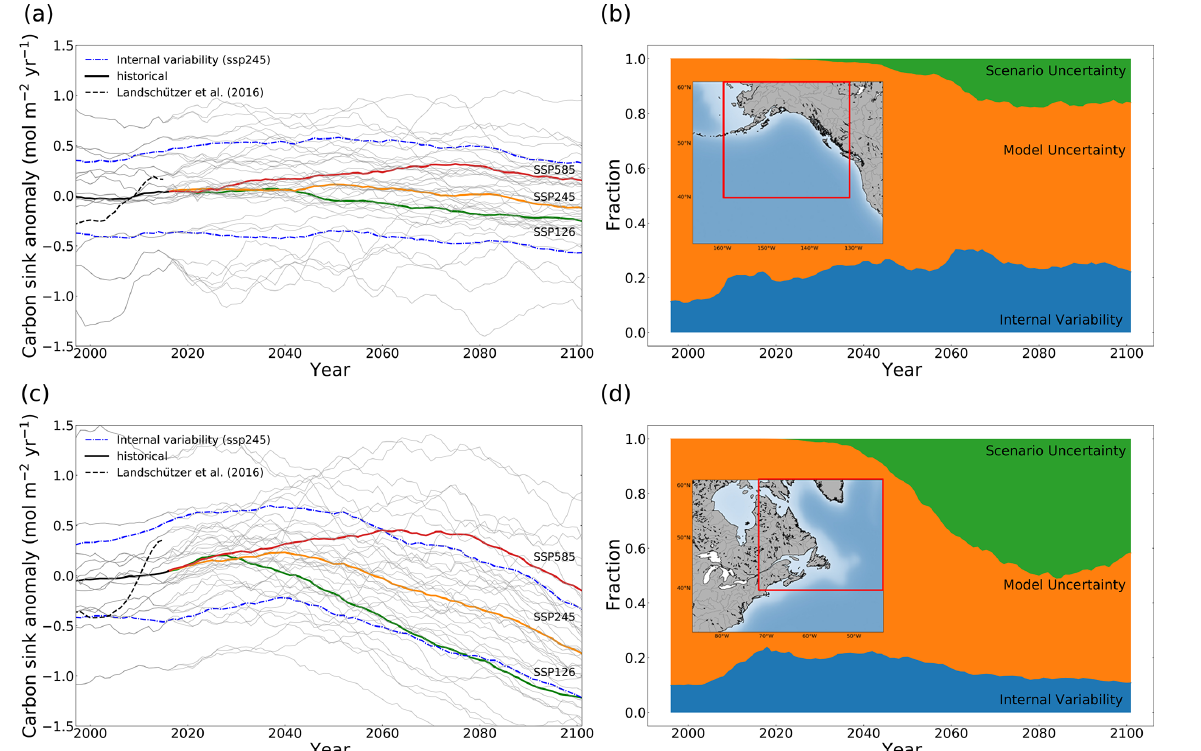
Figure 4. (a, c) Thick lines are multi-model mean time series of anomalies relative to the 1995–2015 mean. All model time series averaged for the means are plotted in grey lines in the background. The black dashed line shows the Landschützer et al. (2016) SOM-FFN product. The blue dashed line shows the internal variability measured as 2 times the standard deviation across all 50 members of the CanESM5 SMILE only for ssp245 here. (b, d) Time series showing the breakdown of uncertainty to different sources with time. The internal uncertainty and model uncertainty are averaged for different scenarios. (a, b) NE Pacific (40–60 ◦ N, 130–160 ◦ W). (c, d) NW Atlantic (40–60 ◦ N, 40–70 ◦